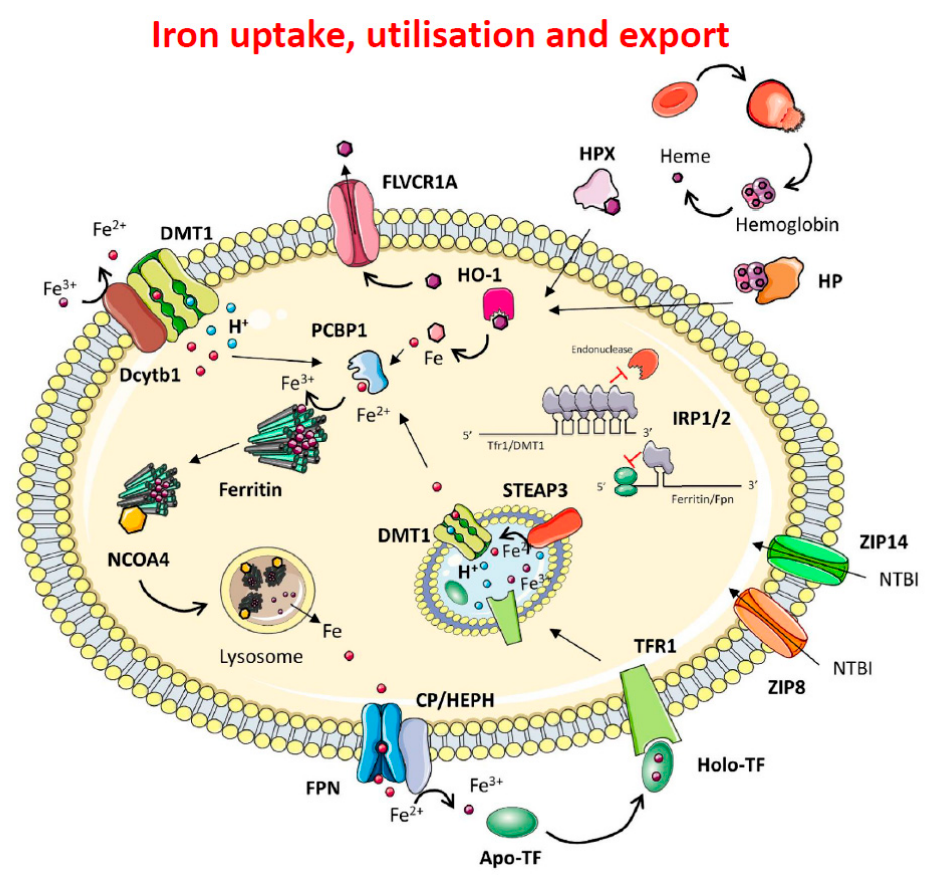
Figure 1. Mechanisms of iron import, handling and export. Dietary ferric iron is reduced to ferrous iron by DCYTB and imported via DMT1. Once in the cytosol, iron is chaperoned by PCBP1 and